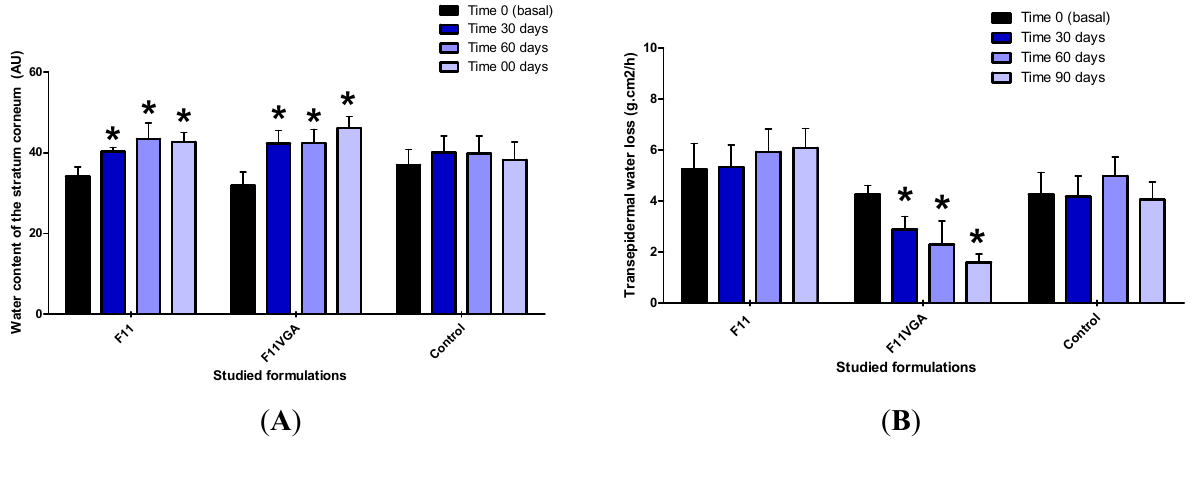
Figure 2. Mean and confidence interval 95% (CI95%) achieved after 30, 60 and 90 days of daily application of studied formulations for the parameters: water content of the stratum corneum ( A ), transepidermal water loss ( B ) and number and width of wrinkles—Sew ( C ), evaluated on the forearms of the volunteers (N = 45